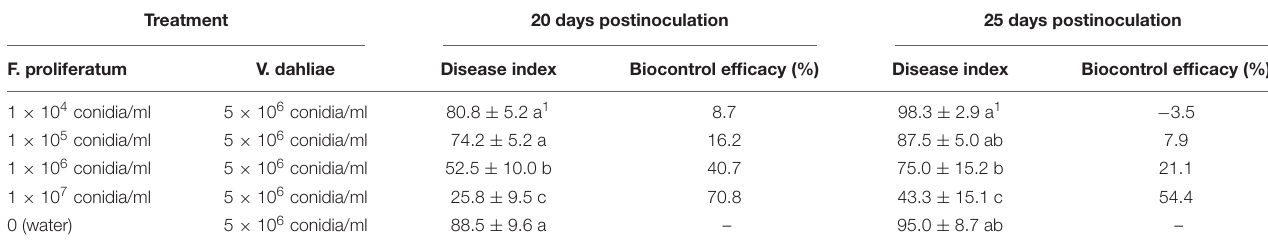
TABLE 5 | Effect of different conidial concentrations of F. proliferatum 10R-7 on suppression of cotton Verticillium wilt caused by V. dahliae in greenhouse. Treatment 20 days postinoculation 25 days postinoculation F.